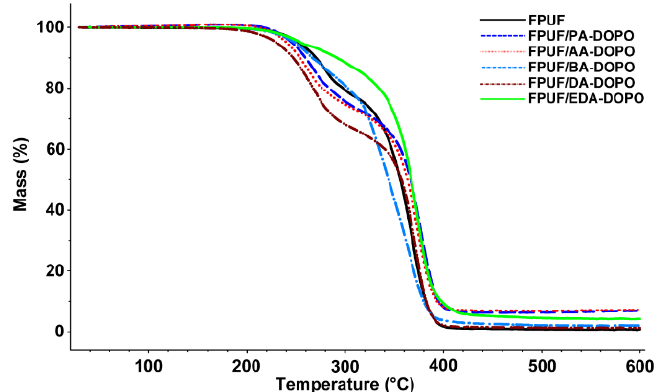
Figure 3. TGA curves of treated FPUF with flame retardant derivatives of DOPO compound in comparison to pure FPUF under N 2 atmosphere.